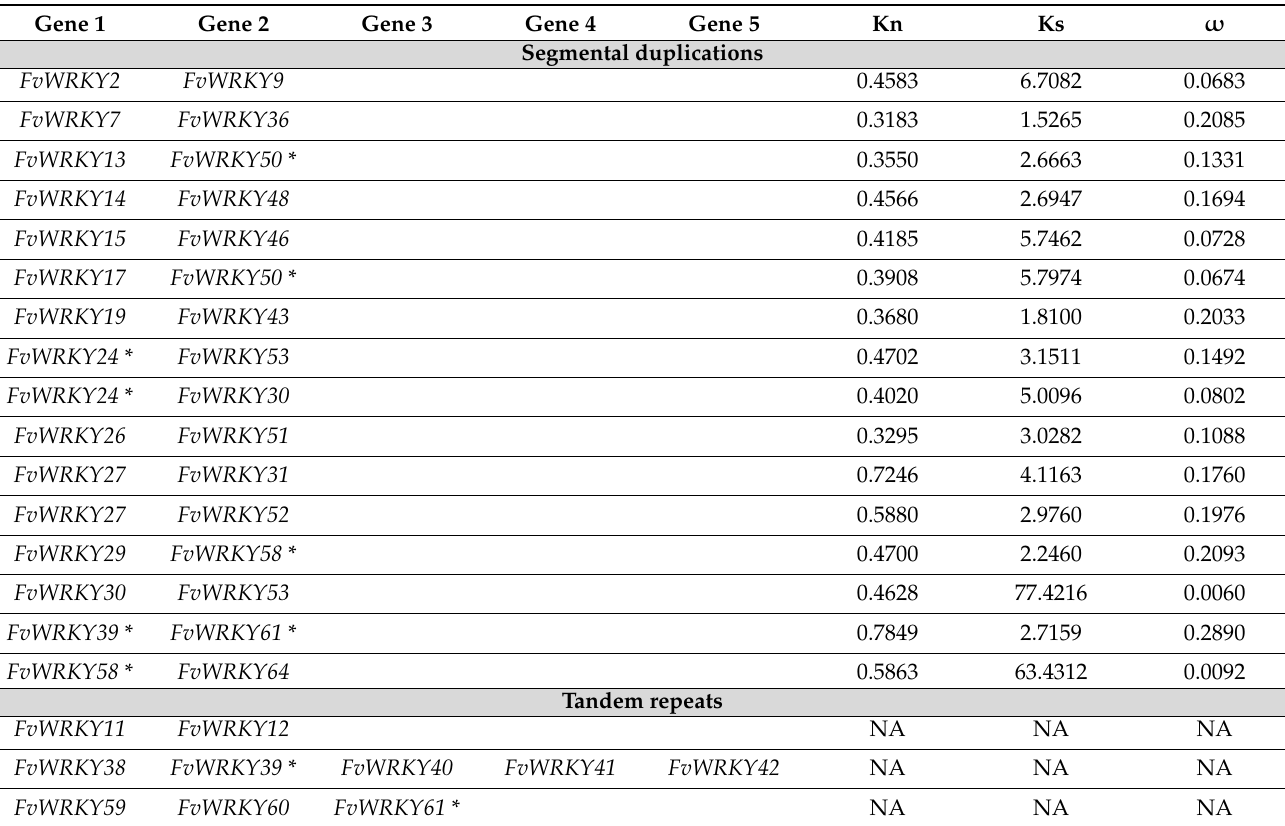
Table 1. FvWRKY gene duplications. Synmap2 did not provide the nucleotide substitution values (Kn, Ks) nor ω for tandemly duplicated genes. Genes marked with asterisks are shared by different duplicate